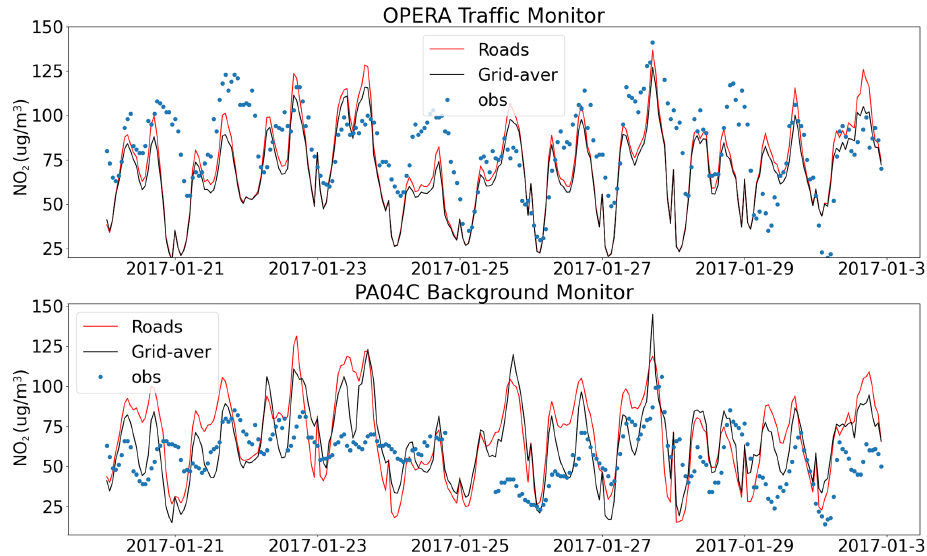
Figure 10. The 10d hourly time series of modeled and measured NO 2 (µgm − 3 ) surface concentrations. The top panel compares simulations with observations over a traffic monitor site, while the bottom panel over a background monitor site of the AIRPARIF air quality network. Concentrations are simulated with the usual CHIMERE calculation where emissions are homogeneous over the grid-cell volumes (black lines) and with the “on-road” component of the subgrid-scale